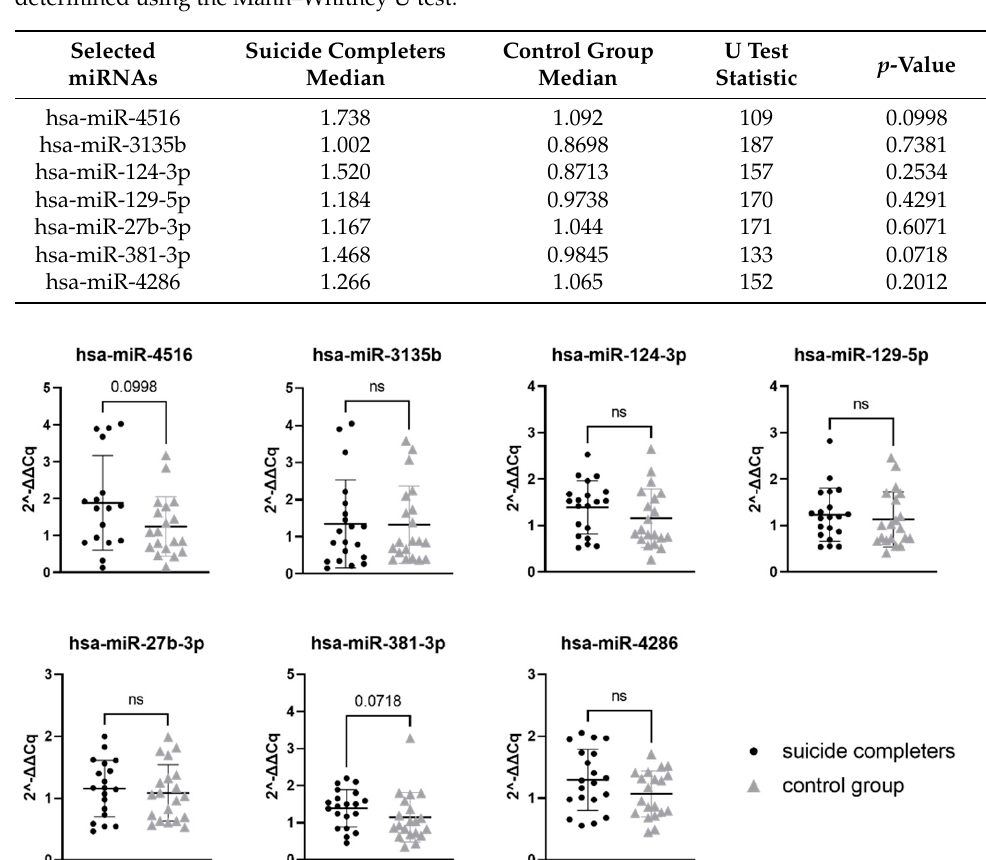
Figure 1. Relative gene expression of selected miRNAs in Brodmann area 10. Data are presented as a scatter plot, with each point being a measure of relative gene expression per subject for both studied groups. Horizontal lines represent mean value ± standard deviation. Data were analysed using the Mann–Whitney U test, with p -values below 0.05 as significant. ns stands for not significant.